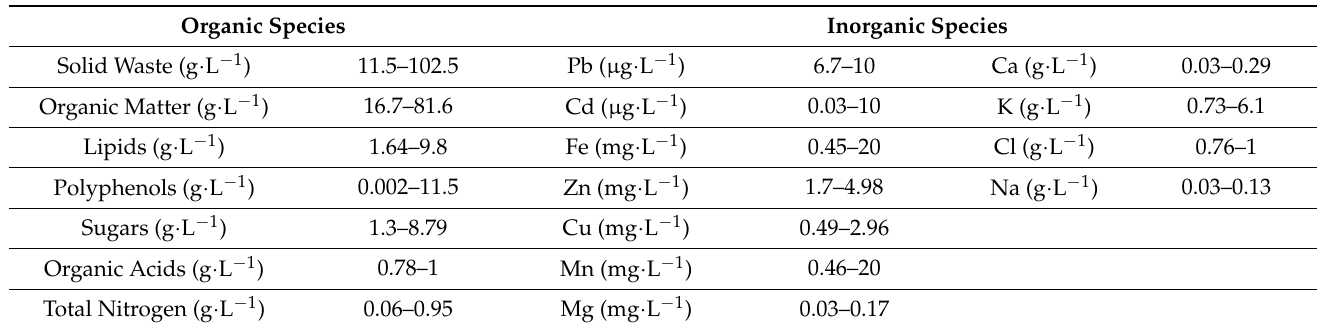
Table 1. Typical physicochemical characterization of the OMW. Reprinted with permission from Ref. [23]. Copyright 2022 Elsevier.